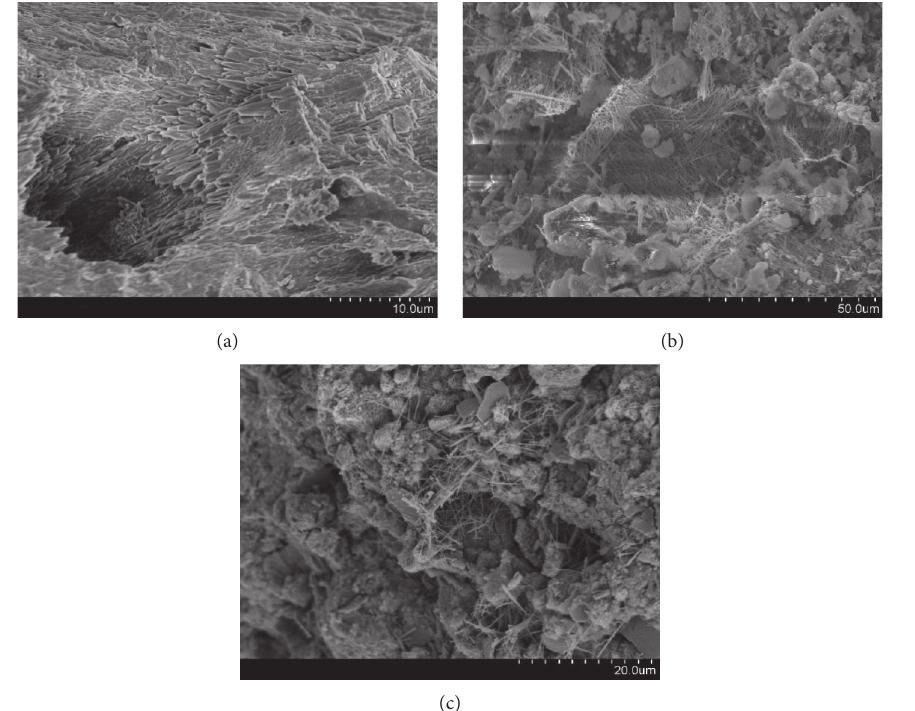
Figure 12: Microstructure analysis. (a) Internal pores of coral sand. (b) Cement-stabilized coral sand with 8% CAS. (c) Cement-stabilized coral sand without expansion